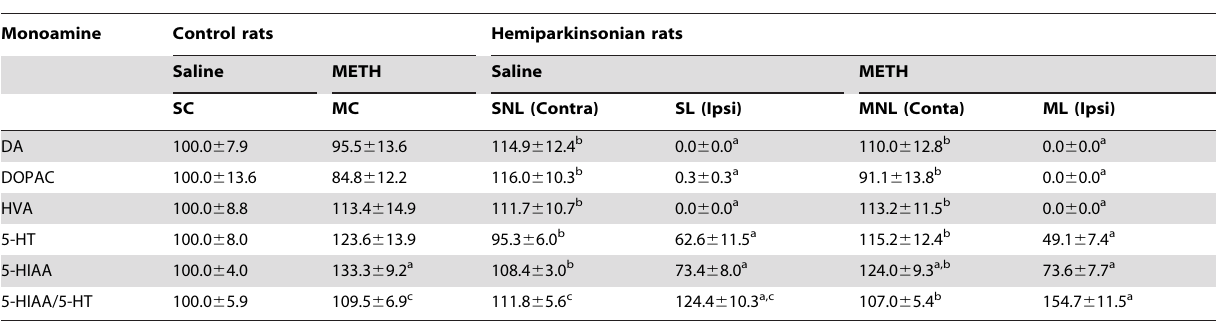
Table 1. Effects of 6-OHDA and METH on striatal monoamine